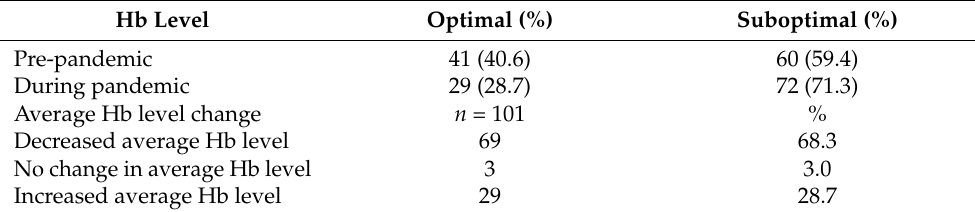
Table 2. Pre-transfusion Hb level of TDT patients before and during